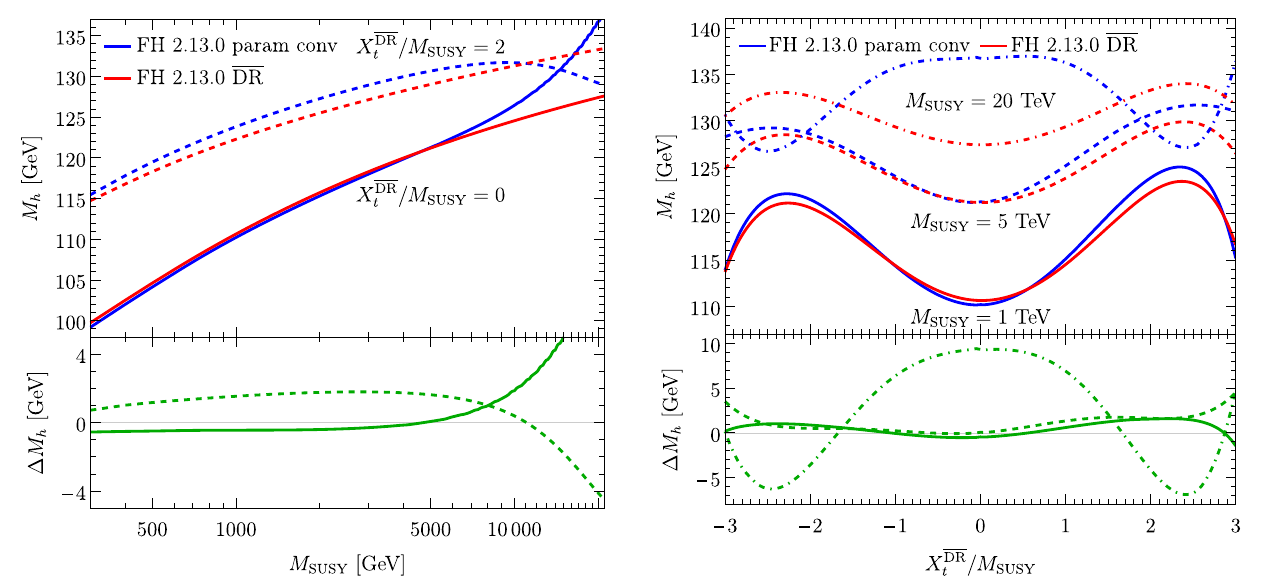
Fig. 1 Left: M h as a function of M SUSY for X DR t / M SUSY = 0 (solid) and X DR t / M SUSY = 2 (dashed). The results of FeynHiggs2.13.0 with a DR to OS conversion of the input parameters (blue) and a DR renormalization of the fixed-order result (red) are compared. Right: Same as left plot, apart that M h is shown in dependence of X DR t / M SUSY